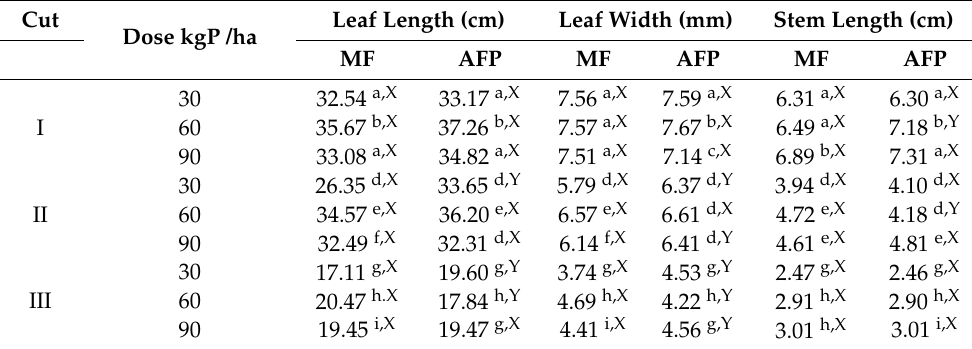
Table 2. Size of leaf length and width and stem length in three successive cuts of Italian ryegrass depending on the type and amount of fertilization.